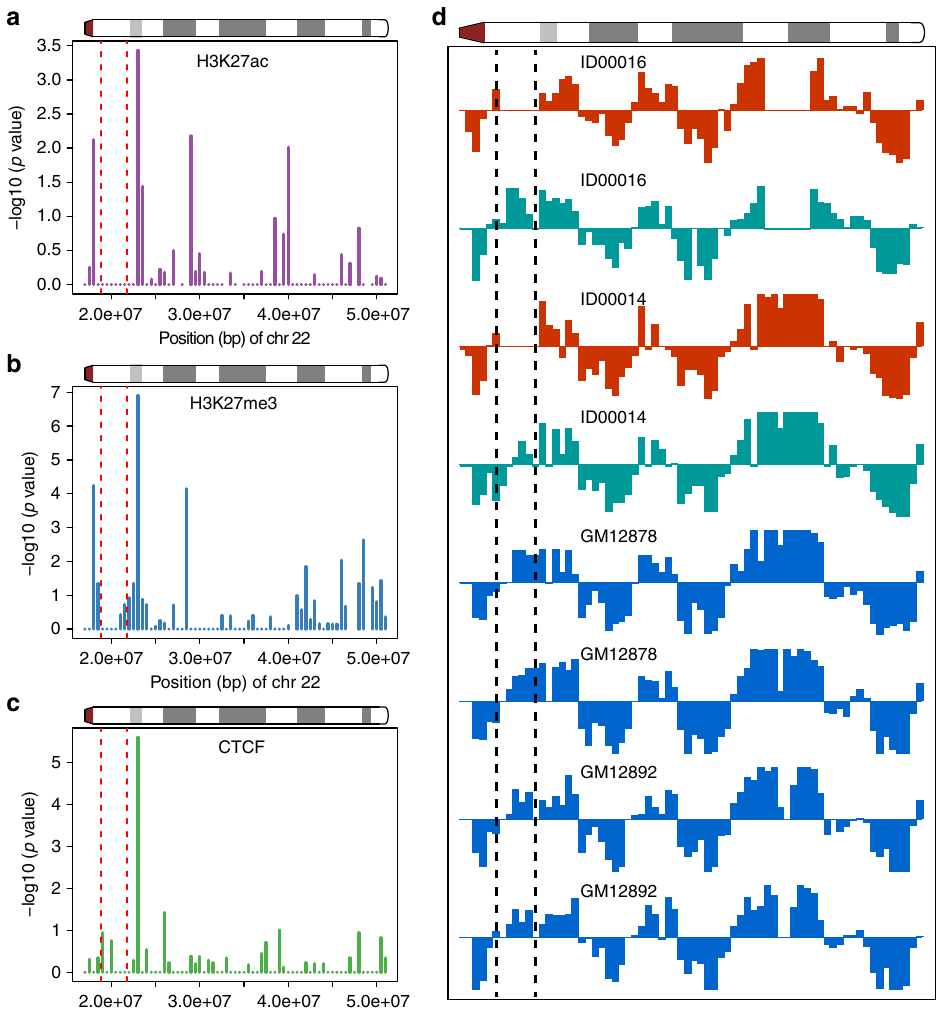
Fig. 3 Distribution of signi fi cantly enriched differential ChIP-Seq signals and haplotype-speci fi c A/B compartments. a H3K27ac histone marks ( n = 5 for 22a11.2del and n = 4 for control cell lines). b H3K27me3 histone marks ( n = 5 for 22a11.2del and n = 4 for control cell lines). c CTCF-binding sites ( n = 4 for 22q11.2del and n = 3 for control cell lines). d A/B compartments for each homologous chromosome 22q. Each bar represents a 500-kbp bin. Red and black dashed lines mark the boundaries of the 3-Mbp deletion in 22q11.2. Shown in d is the fi rst eigenvector for the principal component analysis of the chromosomal contact matrix. x Axis: position on chromosome 22q. y Axis: value of the fi rst eigenvector. The signal from the homologous chromosome 22q with 22q11.2 deletion and the intact chromosome 22q are shown in red and turquoise, respectively, for patients (ID00016 and ID00014). Signals from the homologous chromosomes 22q of the controls are in